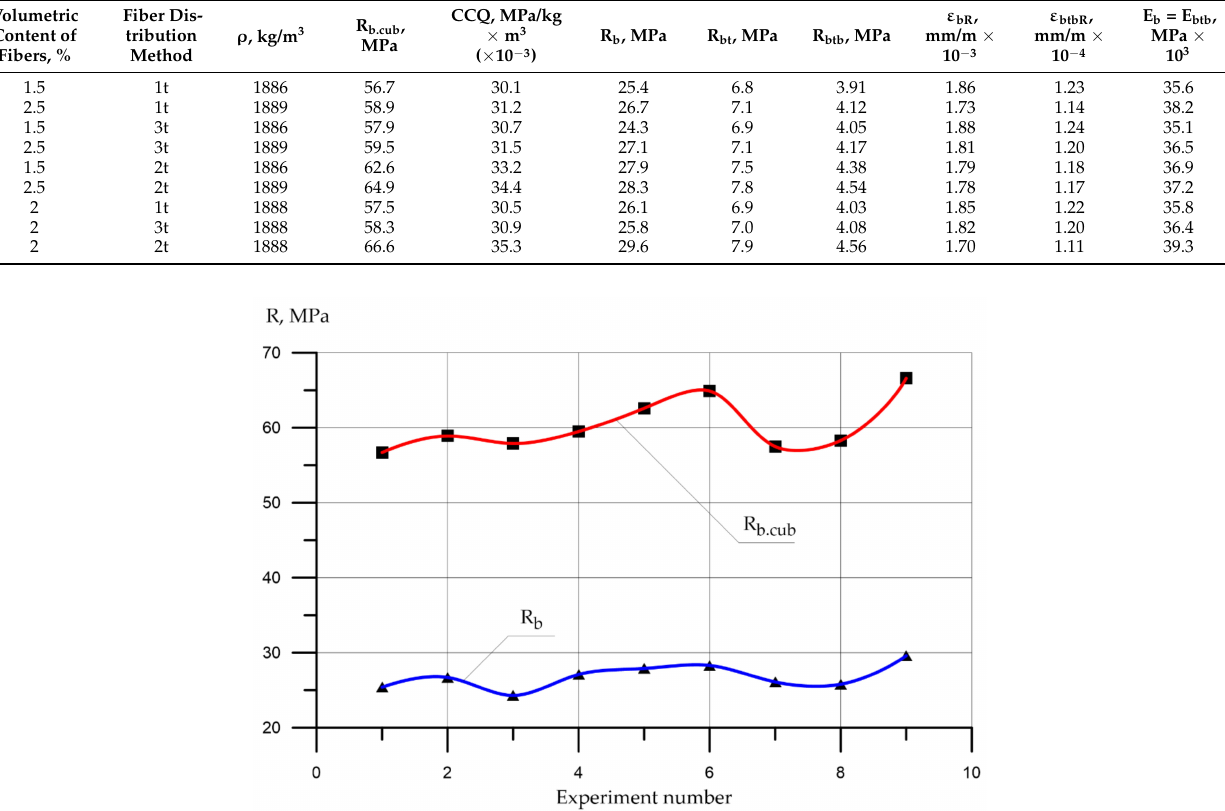
Figure 8. Change in the compressive strength and the prismatic LFRC on a combined aggregate depending on the volumetric content of fiber-reinforced concrete and the method of its distribution during the preparation of a fiber-reinforced concrete